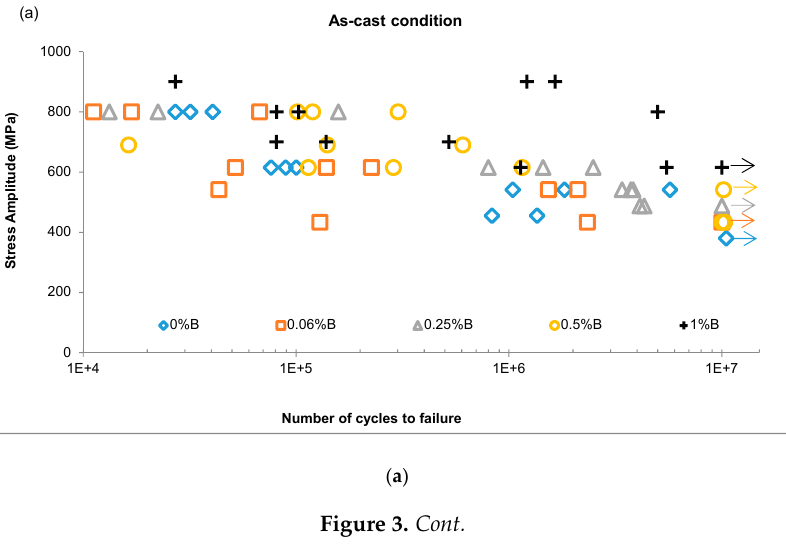
Figure 2. Normal stress (MPa) on the fatigue sample for a load of 50 N.